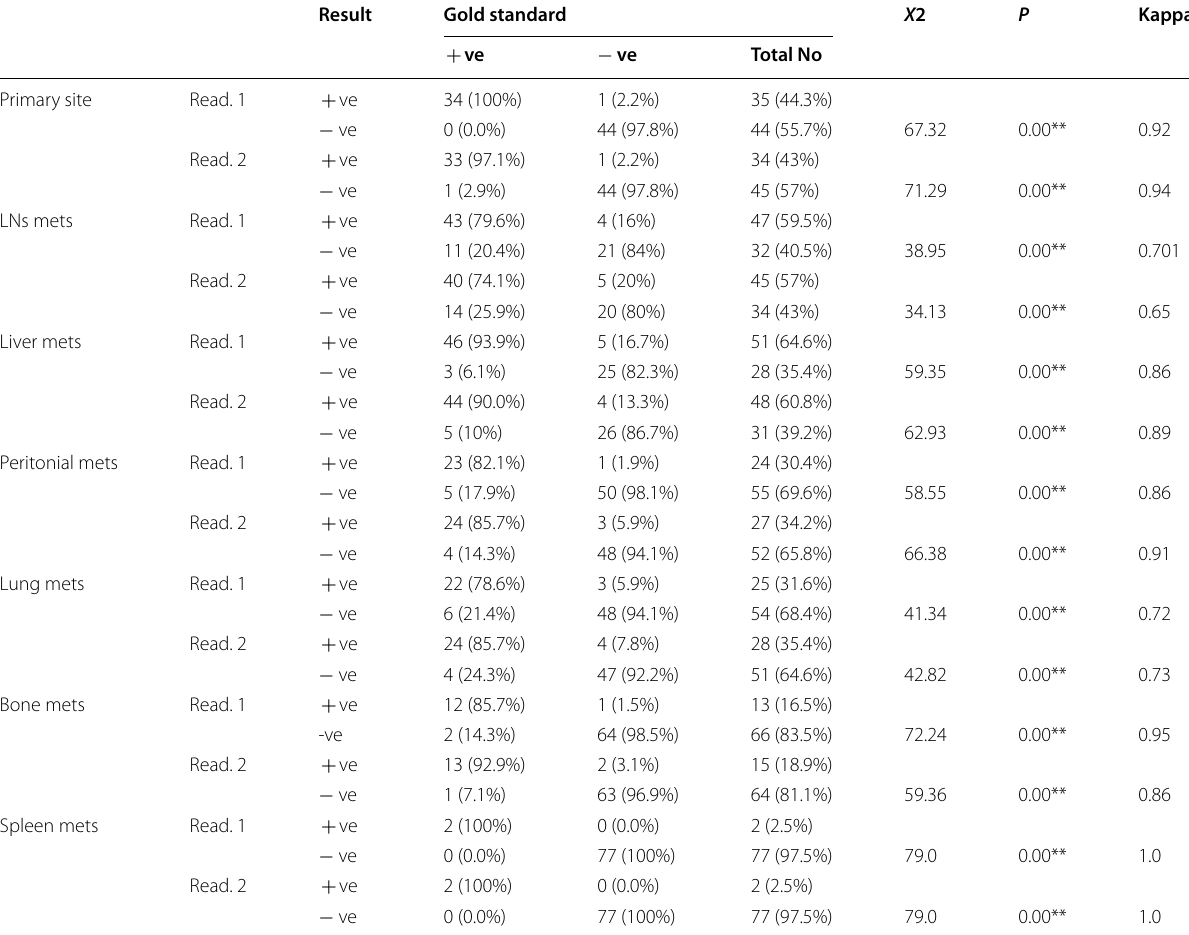
Table 6 Agreement and association between gold standard and PET/CT scan readers Result Gold